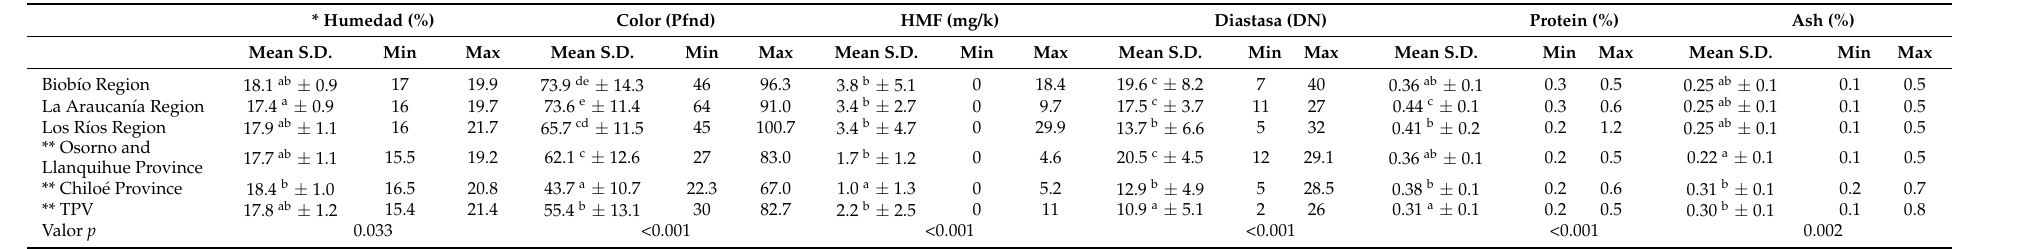
Table 5. Chemical composition of honeys produced in Chile’s central southern